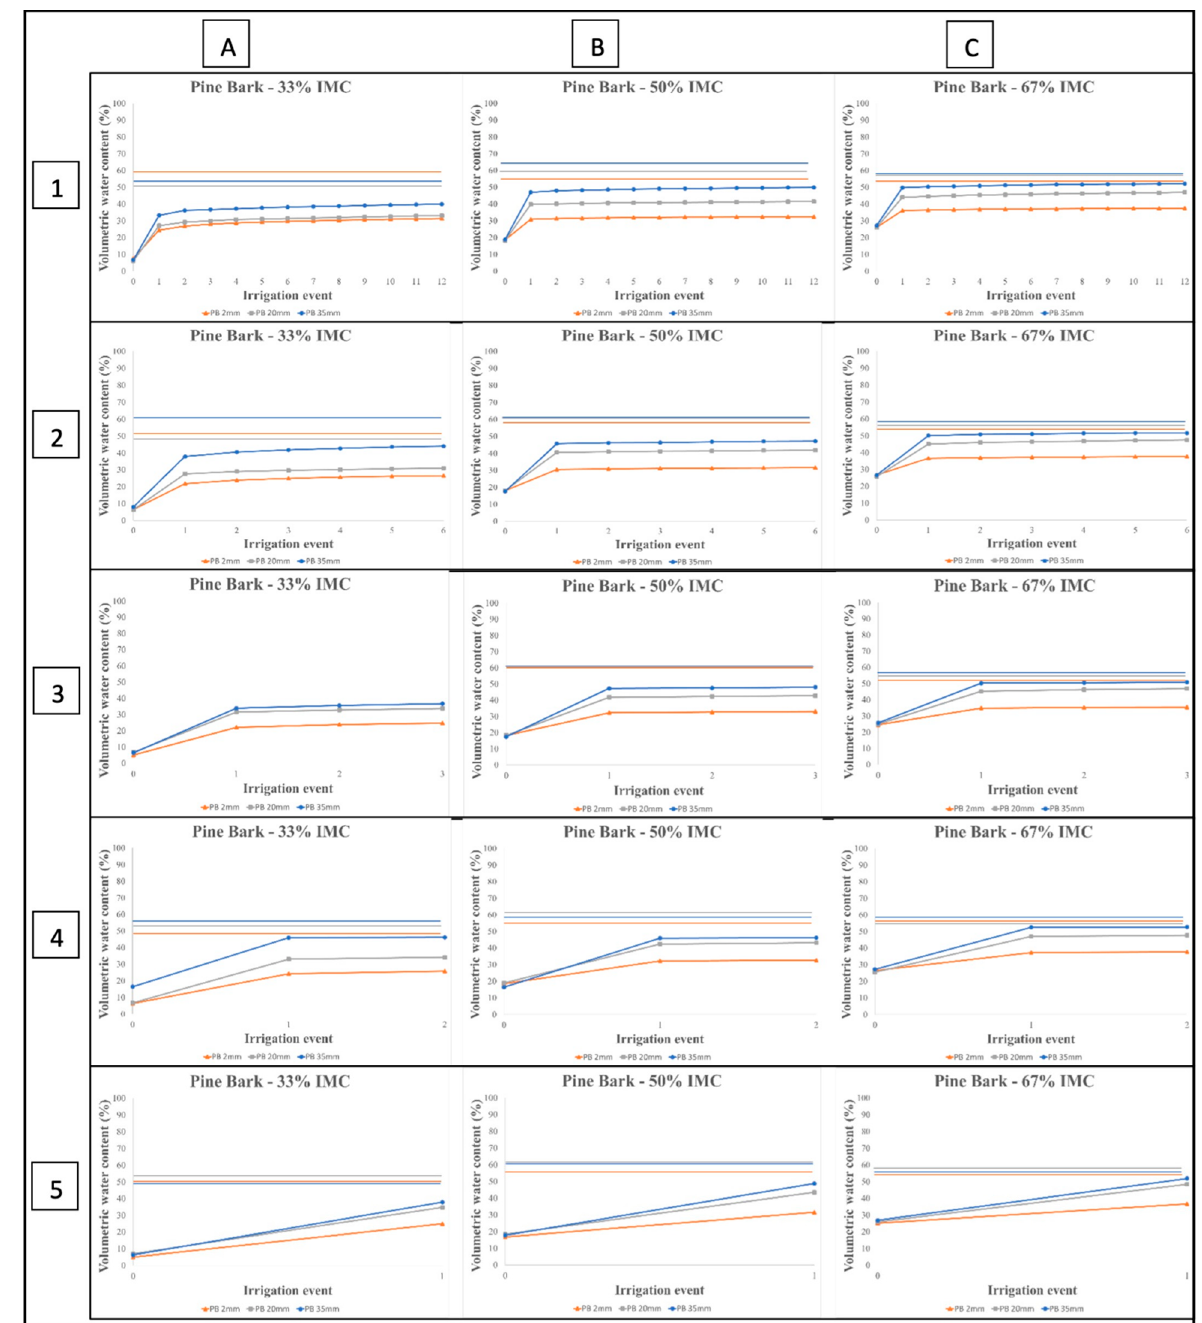
Figure 4. Substrate waters capture volumetric water content curves for pine bark over three initial moisture contents (IMC) of ( A ) 33%, ( B ) 50%, and ( C ) 67%, three irrigation water levels of 2 mm (orange), 20 mm (gray), and 35 mm (blue), and at five irrigation pulse durations of 5 min (1), 10 min (2), 20 min (3), 30 min (4), and 60 min (5). The container capacity for each water level is denoted by the color matched solid bar on the figure.